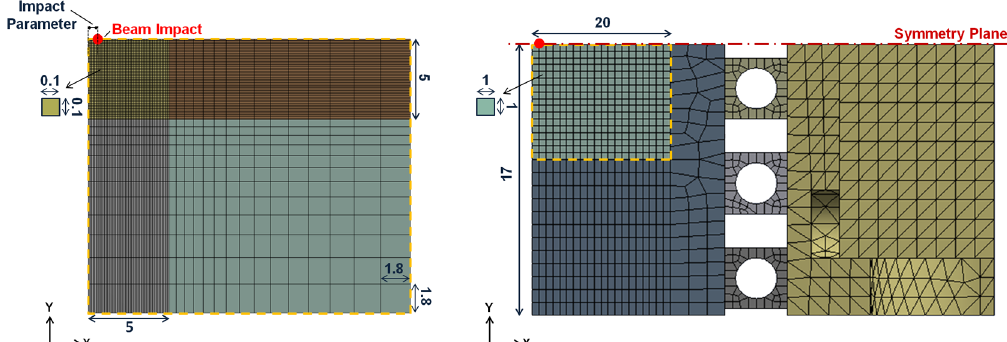
FIG. 7. Finite element discretization of the collimator jaw assembly. A detailed cross-sectional (x-y) view of the collimator jaw inserts as discretized for the thermal analyses (left). A cross-sectional view of the discretized model of the collimator jaw assembly as used for the structural analyses (right). The only difference between the thermal and structural meshes is the mesh of the collimator jaw inserts (enclosed within the dashed line), with a coarser mesh used for the structural analyses. All dimensions are in mm. The total number of elements used for the thermal and structural analyses are 1,056,265 and 368,335,